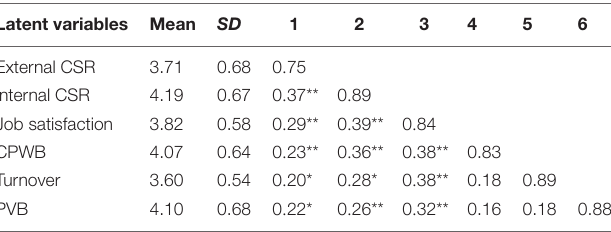
TABLE 4 | Descriptive statistics correlation matrix and test of discriminant